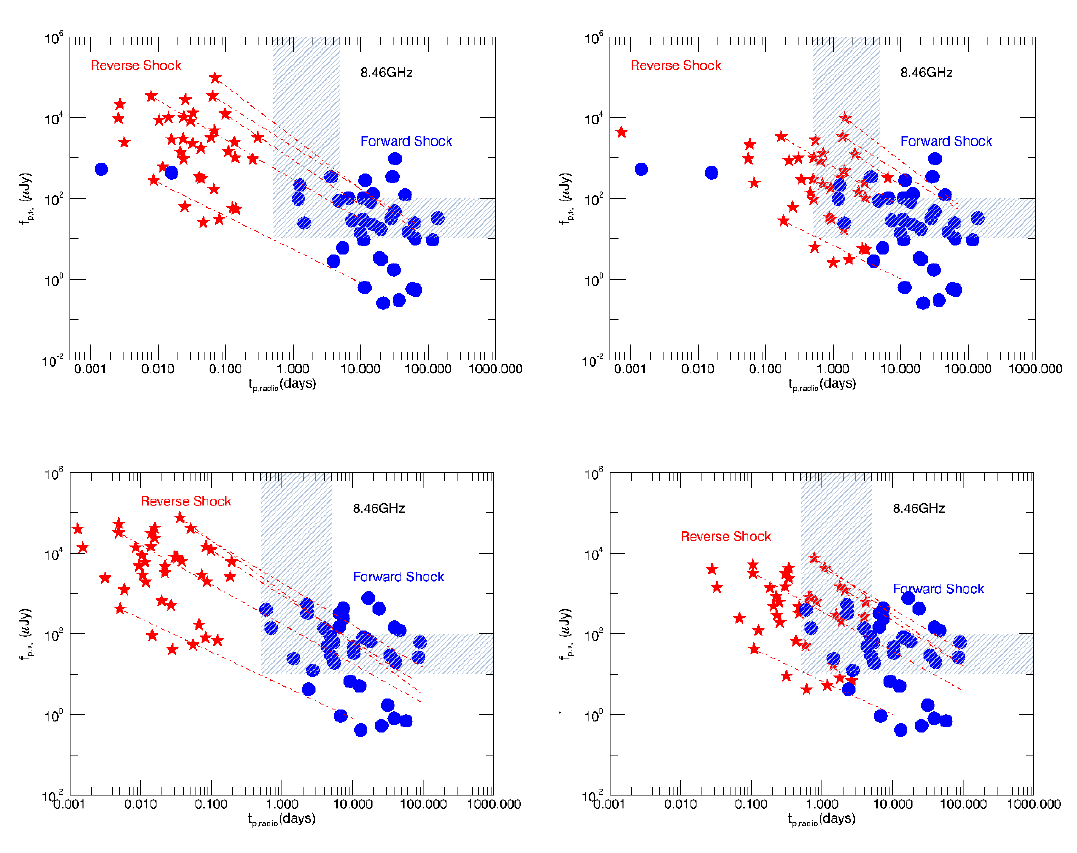
Figure 2. Estimates of the peak flux from the forward (blue dots) and reverse (red stars) shock from synchrotron emission. The vertical shaded region marks the temporal window when radio follow-up observations began for this sample. The horizontal shaded region marks the rough observational flux density limit. Top left panel: (cid:101) B = 0.1, (cid:101) e = (cid:101) B , Γ = 100. Top right panel: (cid:101) B = 0.1, (cid:101) e = (cid:101) B , Γ = 10. The red dashed lines show the flux decay as a function of time for a few representative bursts. Bottom left panel: (cid:101) B = 0.01, (cid:101) e = 0.1, Γ = 100. Bottom right panel: (cid:101) B = 0.01, (cid:101) e = 0.1, Γ = 10. The red dashed lines show the predicted flux decay as a function of time for a few representative